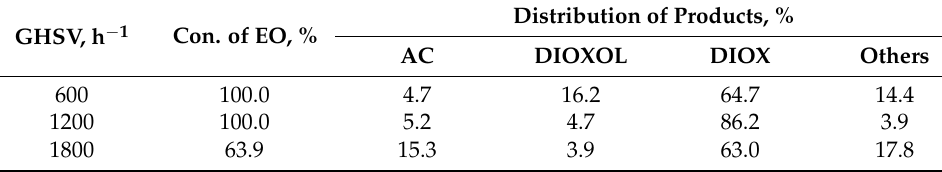
Table 3. Effect of reaction